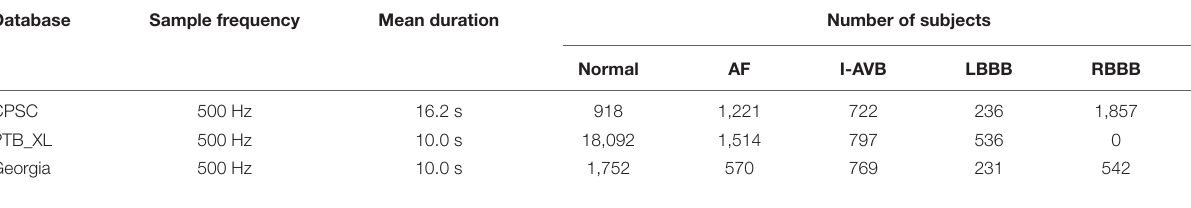
TABLE 8 | Classification performance of different ECG